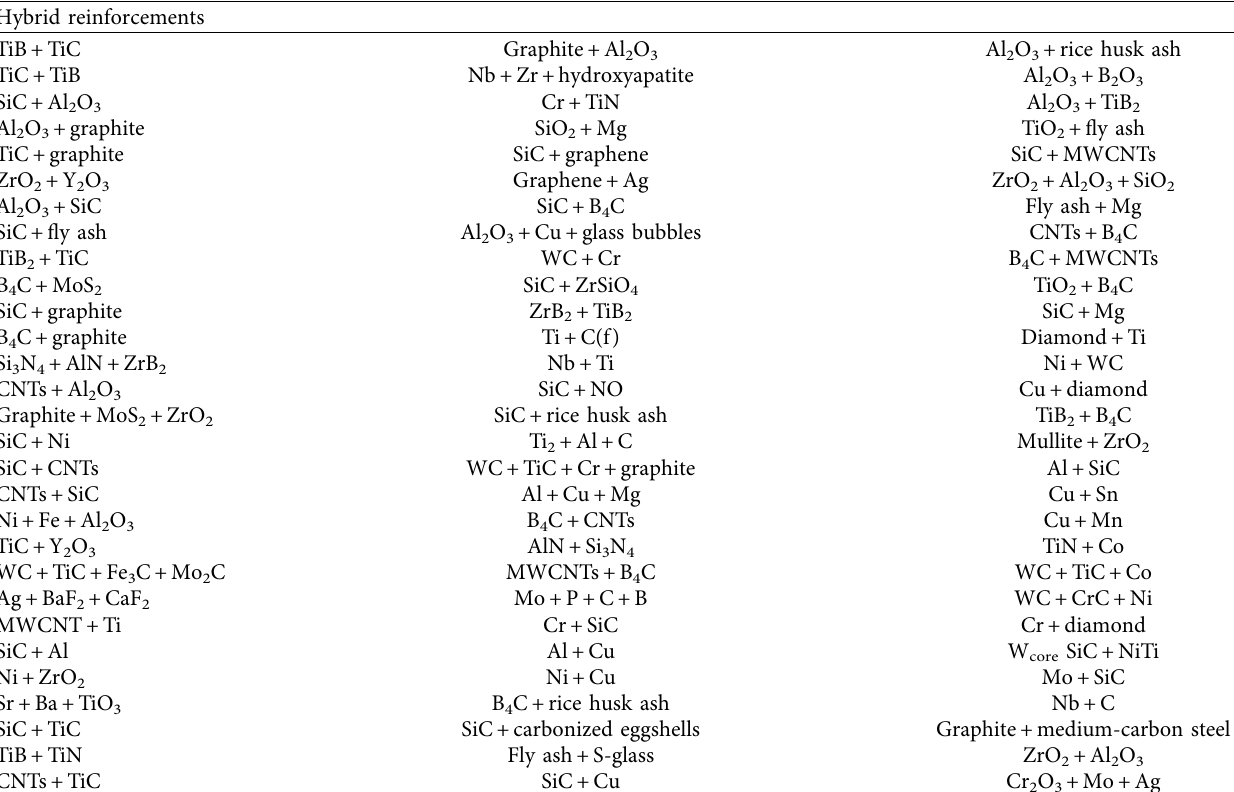
Table 13: Examples of Hybrid reinforcements used with metal matrix (such as Al, Mg, Cu, Fe, Ti, Ni, and their alloys) to produce different HAMCs for different applications [15, 145].